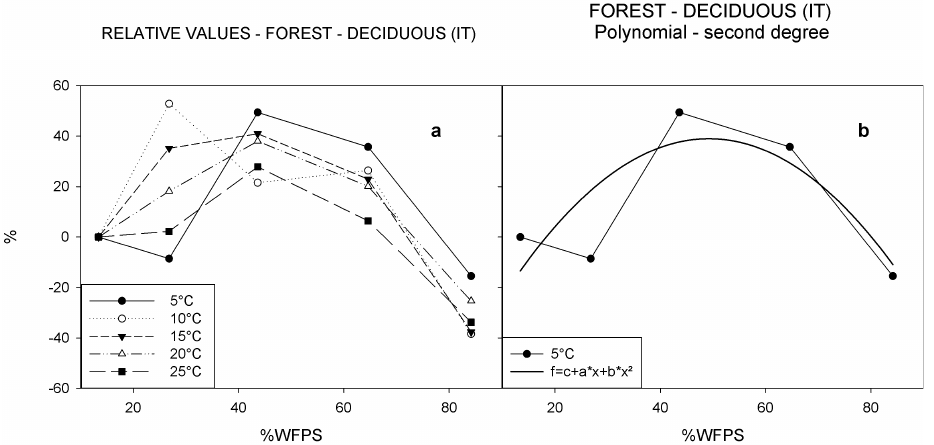
Figure 3. (a) Relative CO 2 flux rates measured for five temperatures and five moisture contents (real values) from the deciduous forest IT-IFo. (b) Polynomial function of second degree fitted of the moisture relationship of relative CO 2 values at 5 ◦